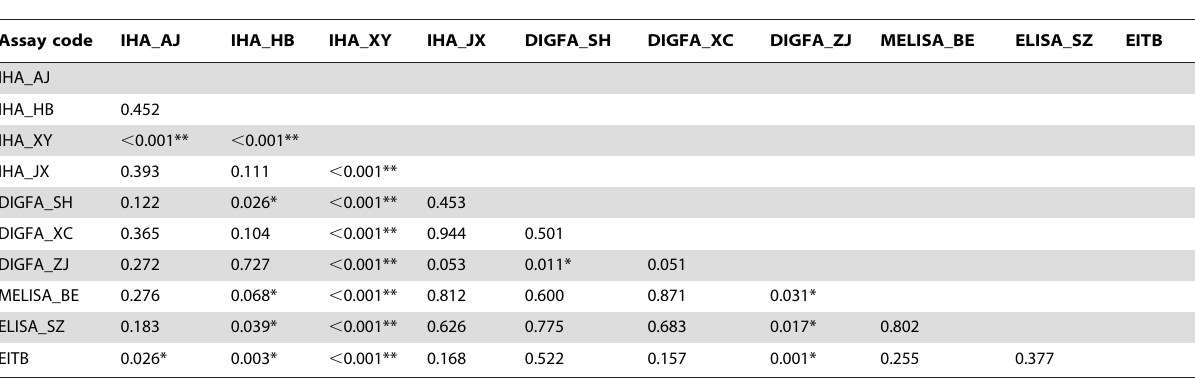
*indicate significant difference; **indicate highly significant